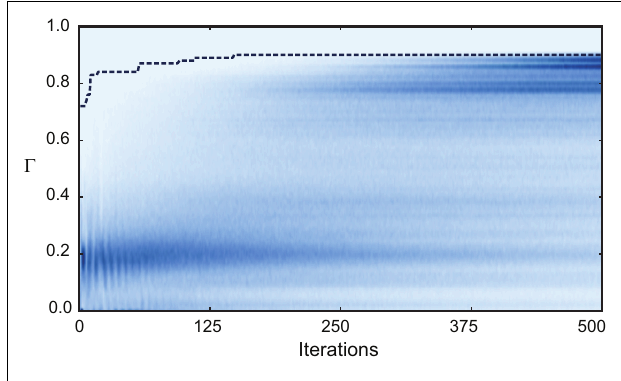
FIGURE 7 | Evolution of the fi tness values of particles during optimization. The color-coded background shows the distribution of the fi tness values ( Γ ) of the 10,000 particles in each of the 500 iterations of the fi tting procedure for trial 3 of challenge B (darker means higher density). The dotted line shows the gamma factor of the best particle. The neuron model was the adaptive threshold IF model. The best gamma factor reaches a plateau after 200 iterations but the other particles continue to